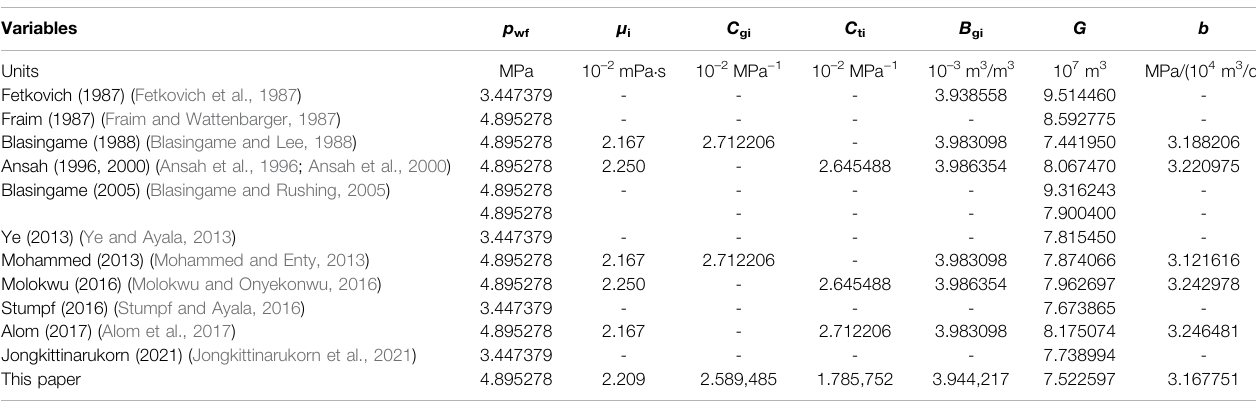
TABLE 3 | Comparison with existing calculation results for the fi eld